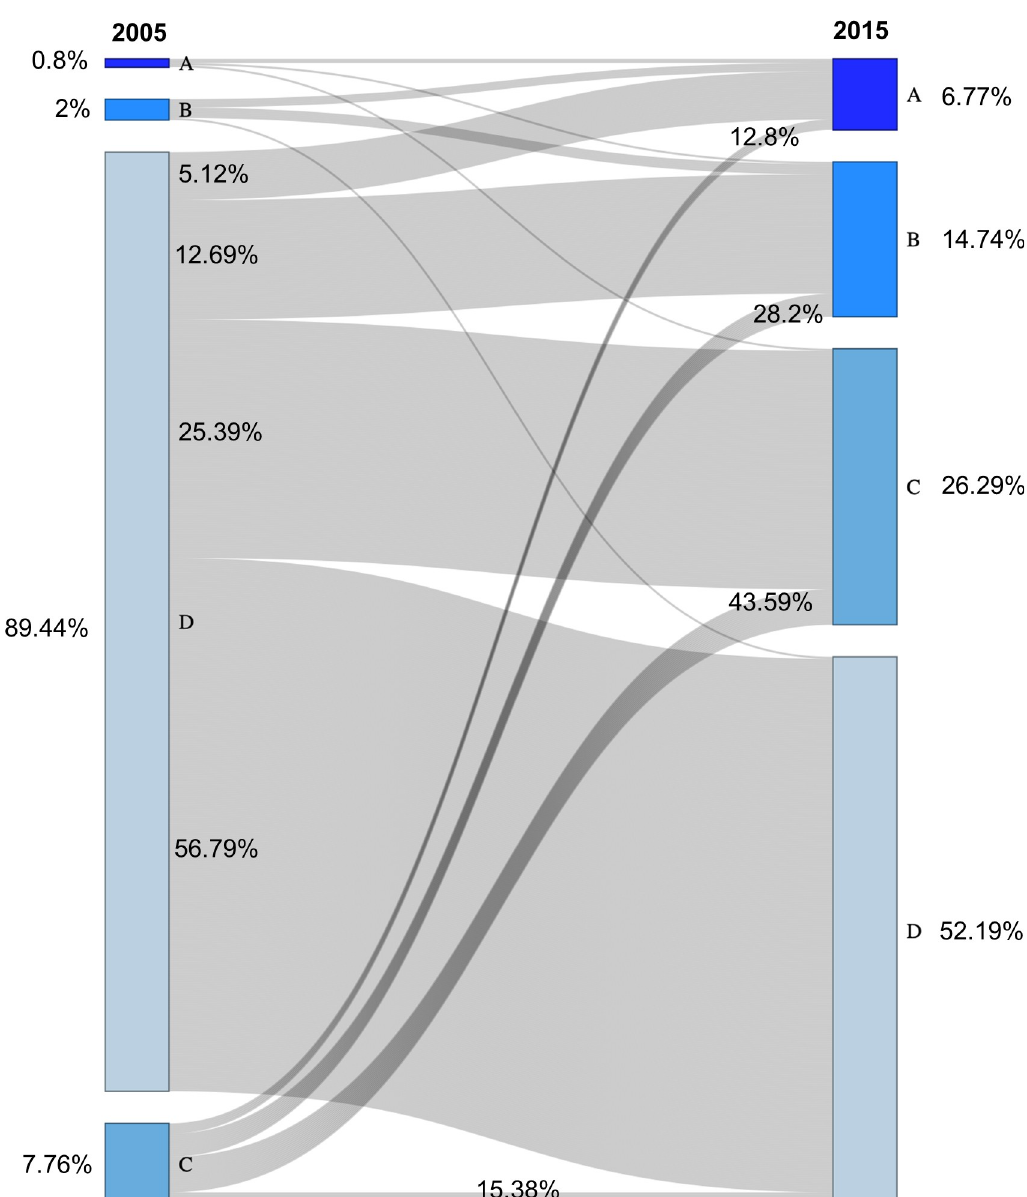
Fig 6. Household poverty trajectory during the study period. Diagram illustrates the movement of households into different categories of income. Note, categories refer to Per capita income per day in USD, A = � 2, B = 1 to 1.99, C = 0.5 to 0.99, and D = <